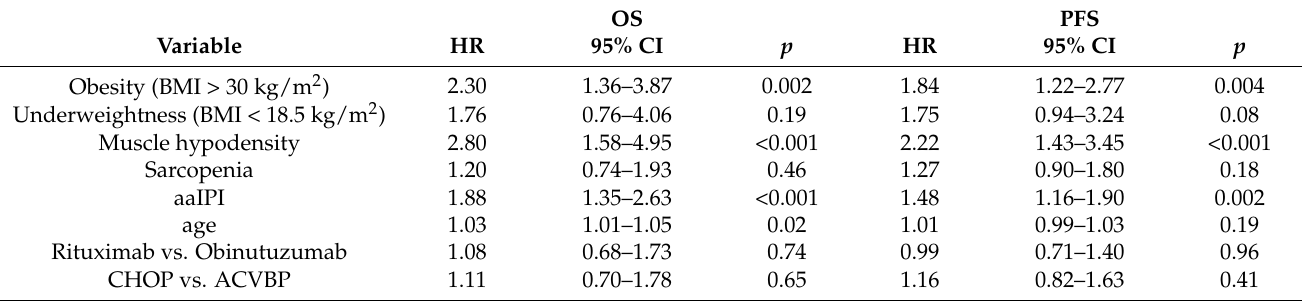
Table 4. Univariate analysis on OS and